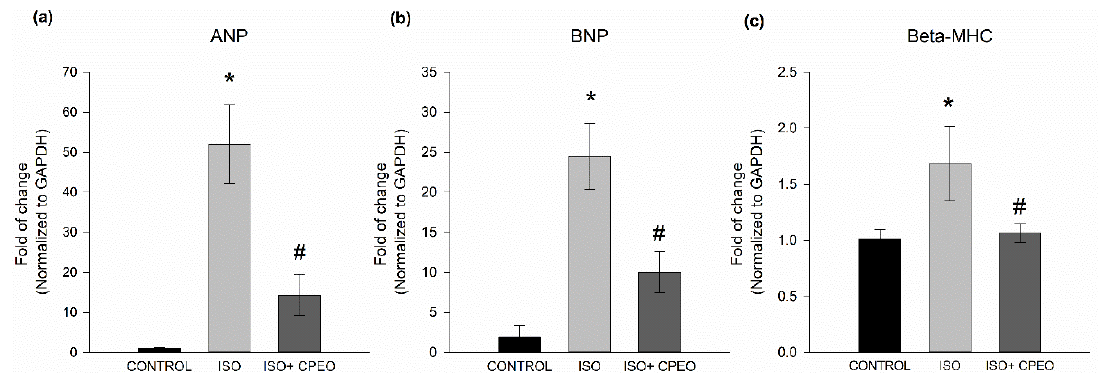
Figure 2. E ff ect of Cymbopogon proximus essential oil (CPEO) and / or isoproterenol (ISO) on hypertrophy markers. Male albino rats were injected intraperitoneally daily with vehicle (Control), PEO (800 µ L / kg / d), ISO (5 mg / kg), or CPEO (800 µ L / kg / d) plus ISO (5 mg / kg). Oil administration was started 4 d prior to ISO administration and continued concurrently thereafter for an additional 3 d. Expression of hypertrophic genes ANP ( a ), BNP ( b ), and β -MHC ( c ) in heart tissue based on mRNA levels measured